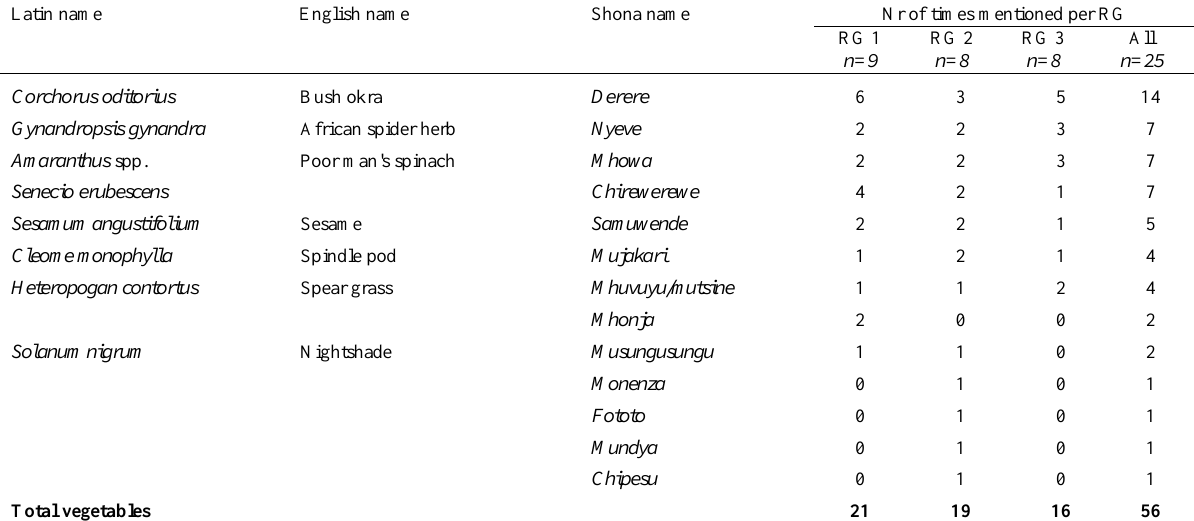
Table A3.2: Wild vegetables, species names and collection scores.